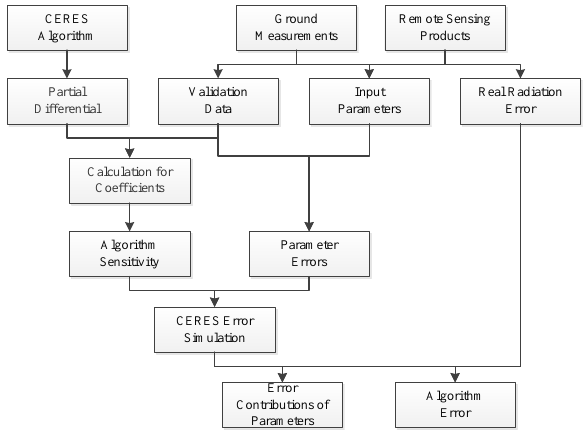
Figure 1. Schematic of the procedure for evaluating the surface